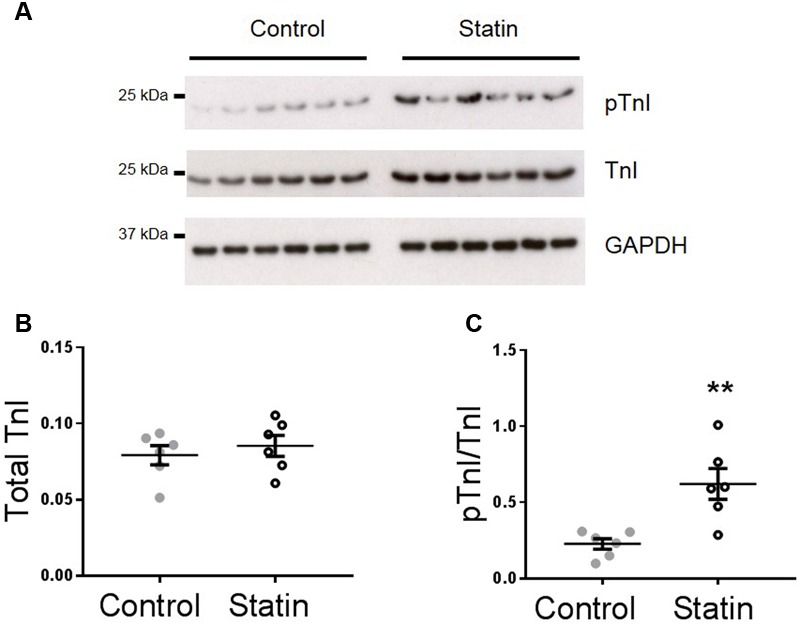
Simvastatin treatment increases phosphorylation of troponin I (TnI). Representative immunoblots (A) and scatter plots showing myocardial levels of total troponin I (B) and Ser23/24 phosphorylated TnI (pTnI) (C) in control and statin-treated animals. Total TnI is normalized to GADPH, pTnI is normalized to total TnI. Plots show mean ± SEM from N = 6 animals per group. ∗∗P < 0.01 vs. control group, Student’s t-test.